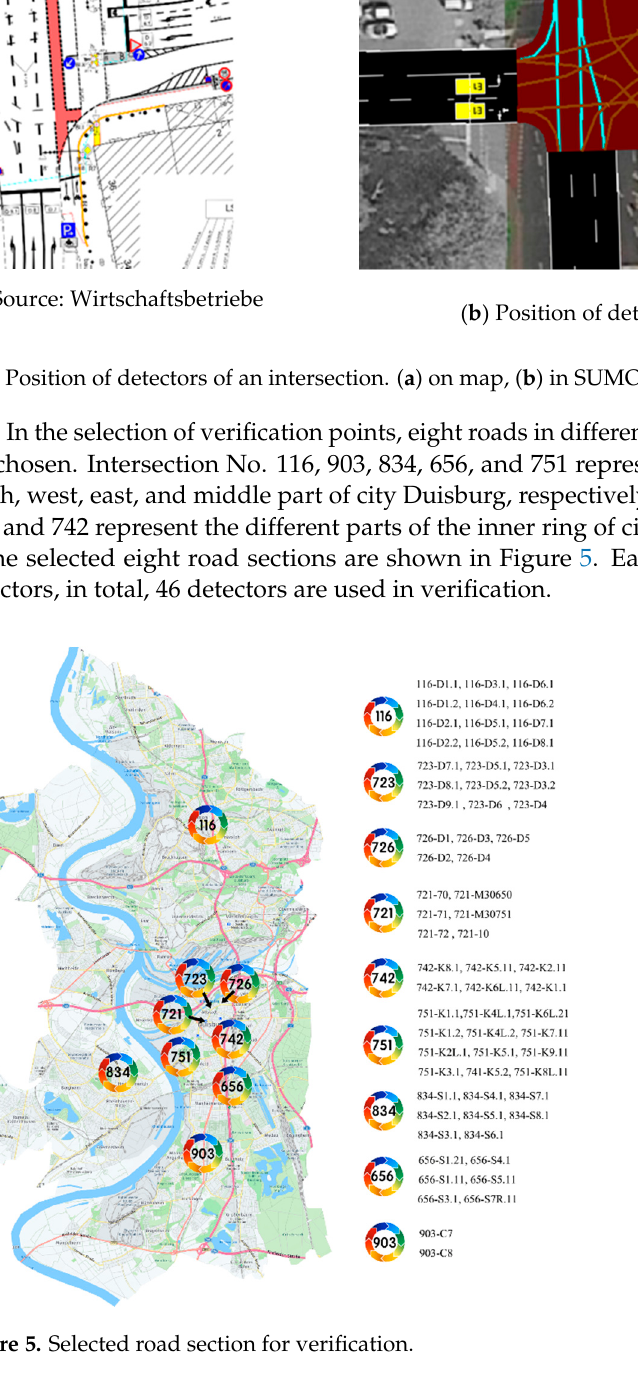
Figure 5. Selected road section for verification.